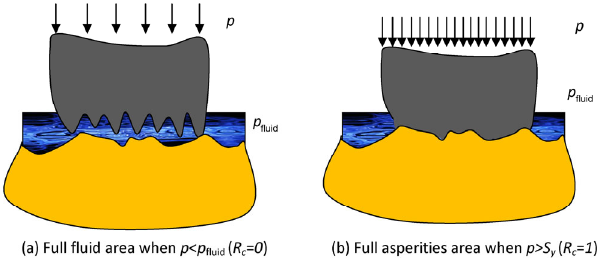
Fig. 11 Extreme cases of the ratio of fluid area and asperities